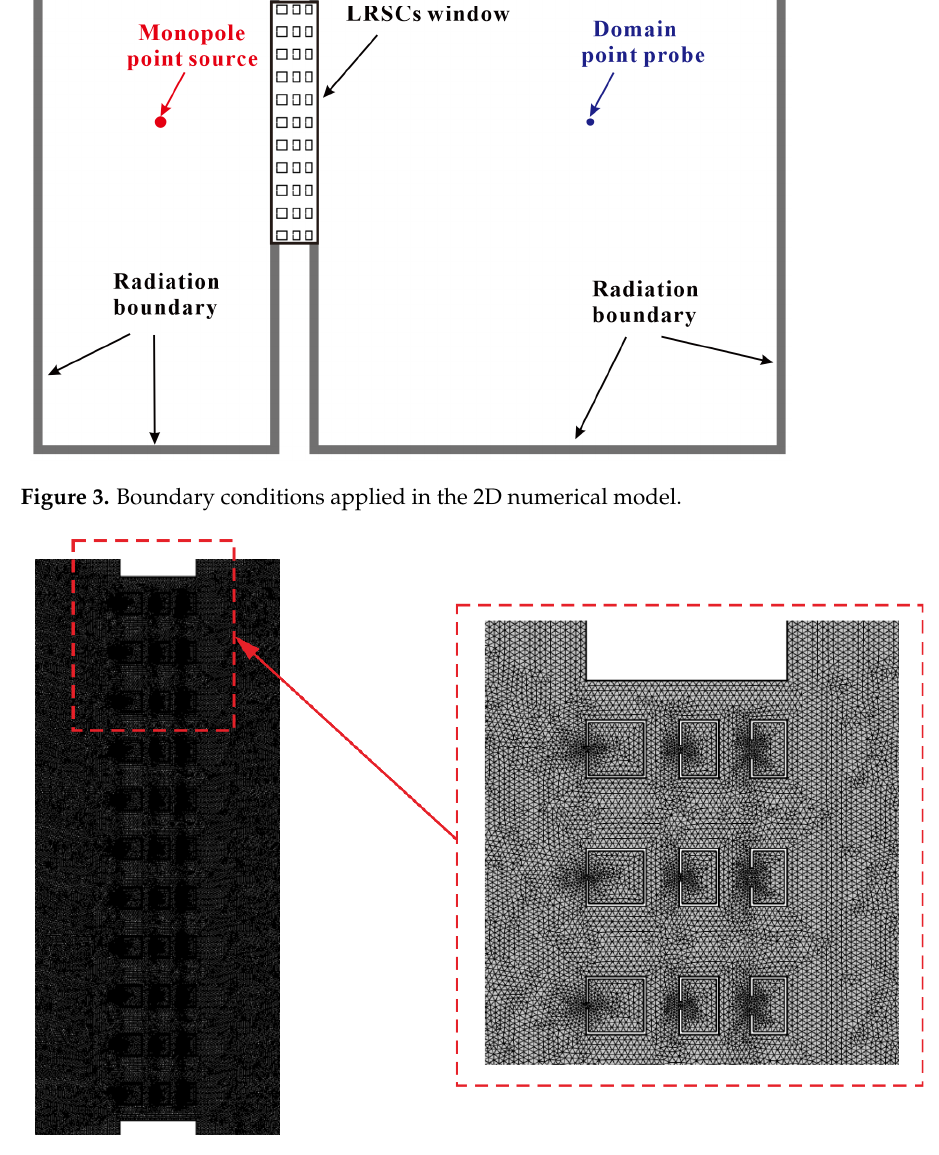
Figure 4. A typical mesh profile in the present study.